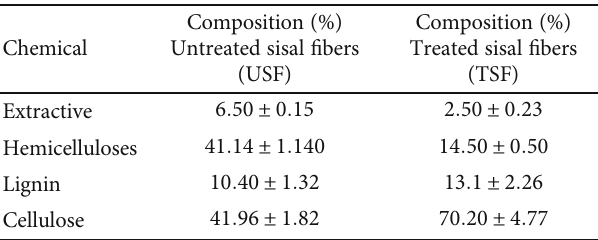
O . 2 2 Table 1: Chemical composition of sisal fi bers (untreated and